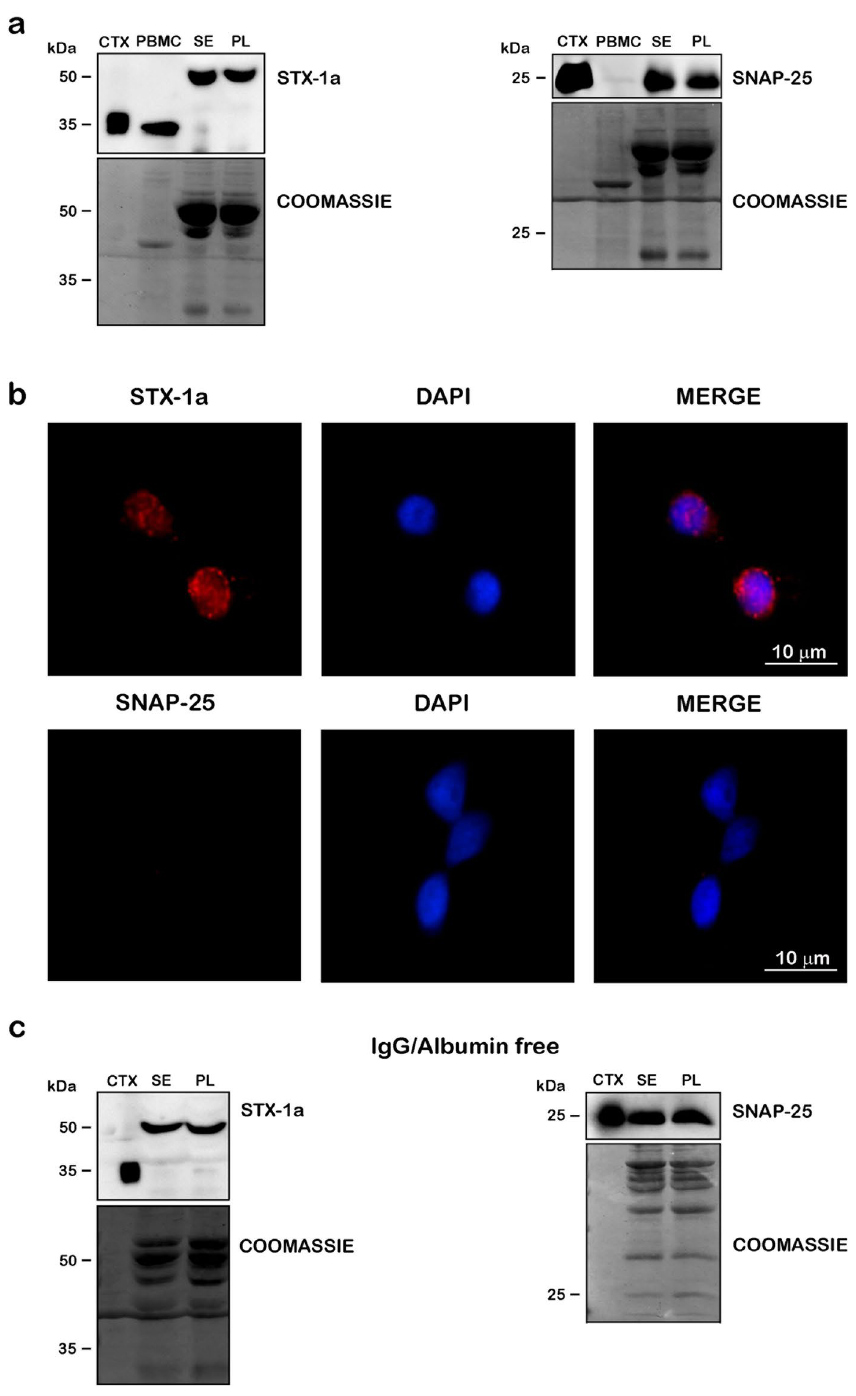
Figure 1. Detection of STX-1a and SNAP-25 in peripheral blood of healthy donors. ( a ) WB analysis of the SNARE proteins in blood components. PBMCs, serum (SE), plasma (PL) and mouse brain cortex lysate (CTX, loaded as positive control) have been immunostained with STX-1a and SNAP-25 antibodies. STX-1a was detected in all blood components, but only in PBMCs at the predicted M.W., while SNAP-25 was observed in serum and plasma but not in blood cells. ( b ) Immunofluorescence analysis of STX-1a and SNAP-25 in PBMCs. Fluorescence analysis of PBMCs confirms the presence of STX-1a but not that of SNAP-25 (red channels). Nuclei have been labeled with the marker DAPI (blue channels). Original magnification: 60×. Bars correspond to 10 µm. ( c ) WB analysis of STX-1a and SNAP-25 in serum and plasma depleted from IgG and albumin. After the stripping of IgG and albumin from serum and plasma (as shown by Coomassie Blue staining) both STX-1a (at the shifted M.W) and SNAP-25 immune-recognition signals persist. For WB analysis 100 µg of blood components, 0.5 µg of mouse brain cortex lysate and 10 µL of flow through have been loaded in each lane. Uncropped WB and coomassie staining in ( a ) and ( c ) have been reported in Fig. S4